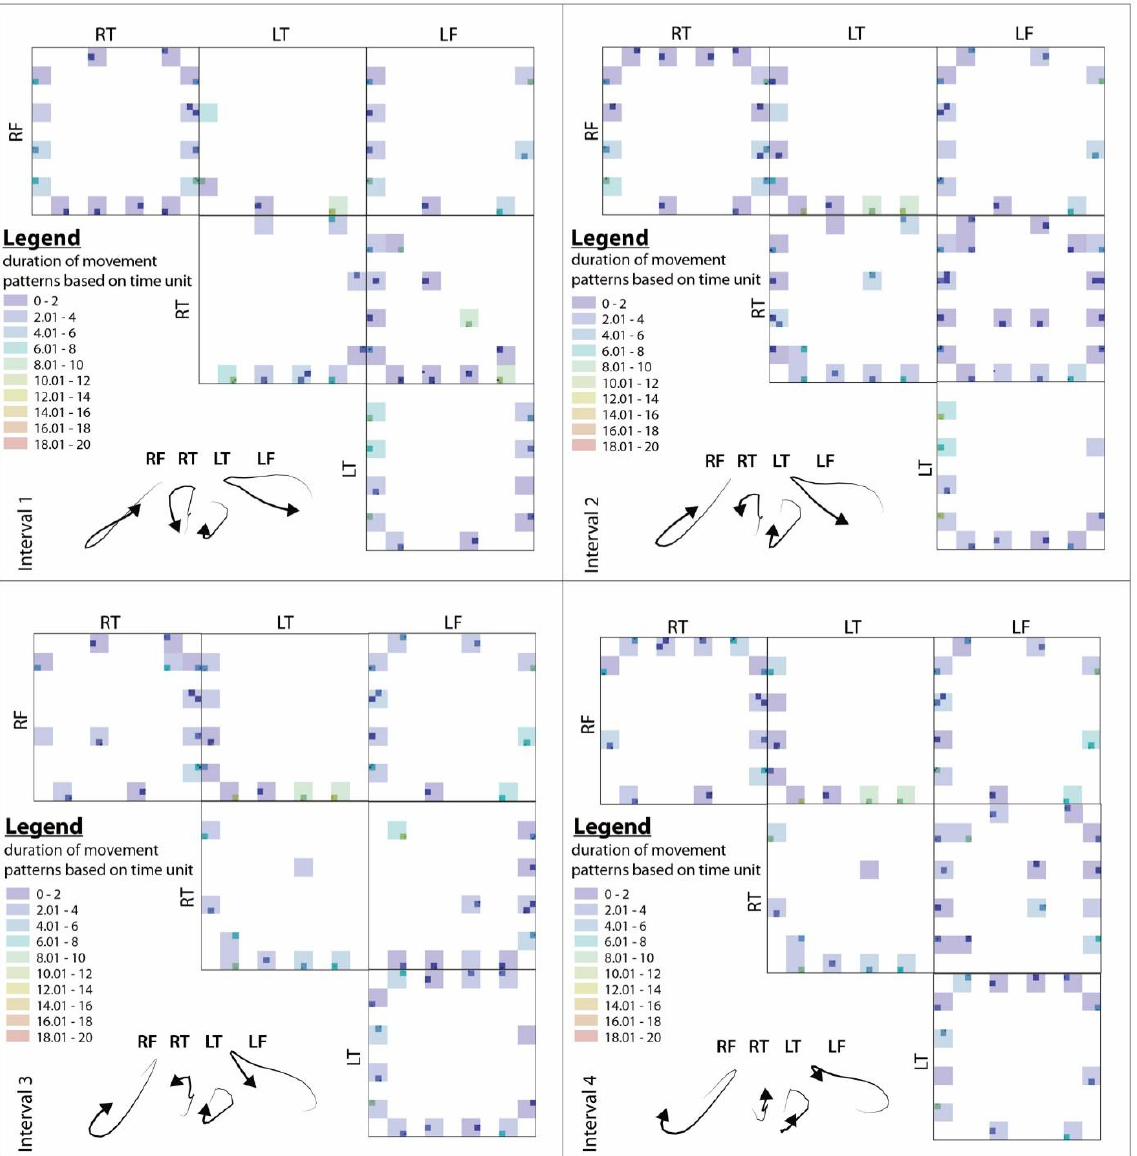
Figure 12. Hyper-SESIs of four equal time intervals of movements based on the duration of QTC movement B